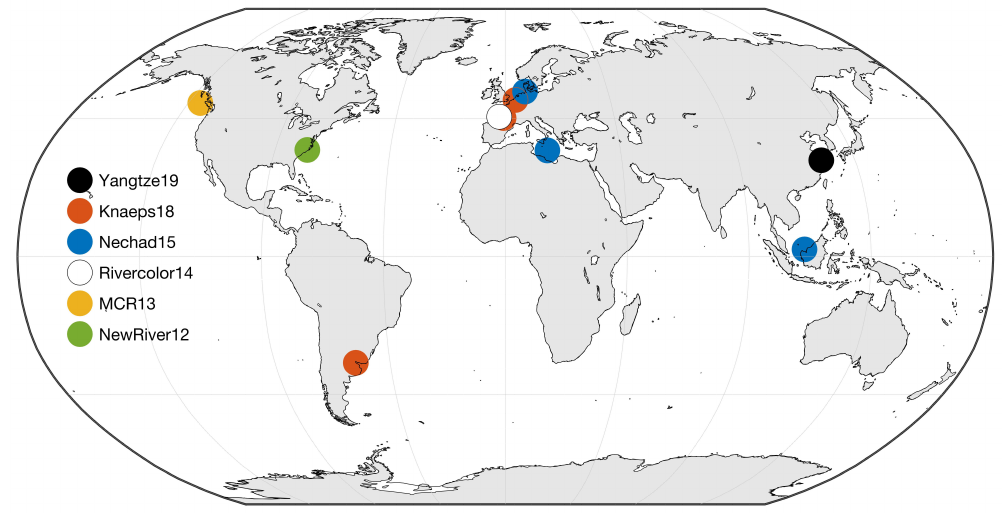
Figure 1. Map of data locations. Dots represent sites at which field data was collected. Information is color-coded based on